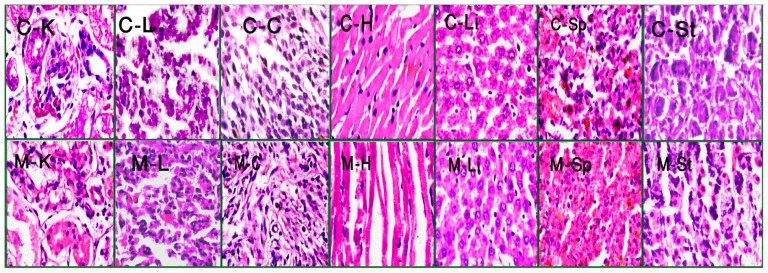
Histopathological photomicrographs of control group and 1000 mg/kg dose group of C. macroptera (×100 magnification).No presence of discernible lesions including inflammation and necrosis were observed. Here, C-K =  Control-Kidney, C-L =  Control-Lung, C-C =  Control-Cecum, C-H =  Control-Heart, C-Li =  Control-Liver, C-Sp =  Control-Spleen, C-St =  Control-Stomach, M-K = 1000 mg/kg dose-Kidney, M-L = 1000 mg/kg dose-Lung, M-C = 1000 mg/kg dose-Cecum, M-H = 1000 mg/kg dose-Heart, M-Li = 1000 mg/kg dose-Liver, M-Sp = 1000 mg/kg dose-Spleen and M-St = 1000 mg/kg dose-Stomach.